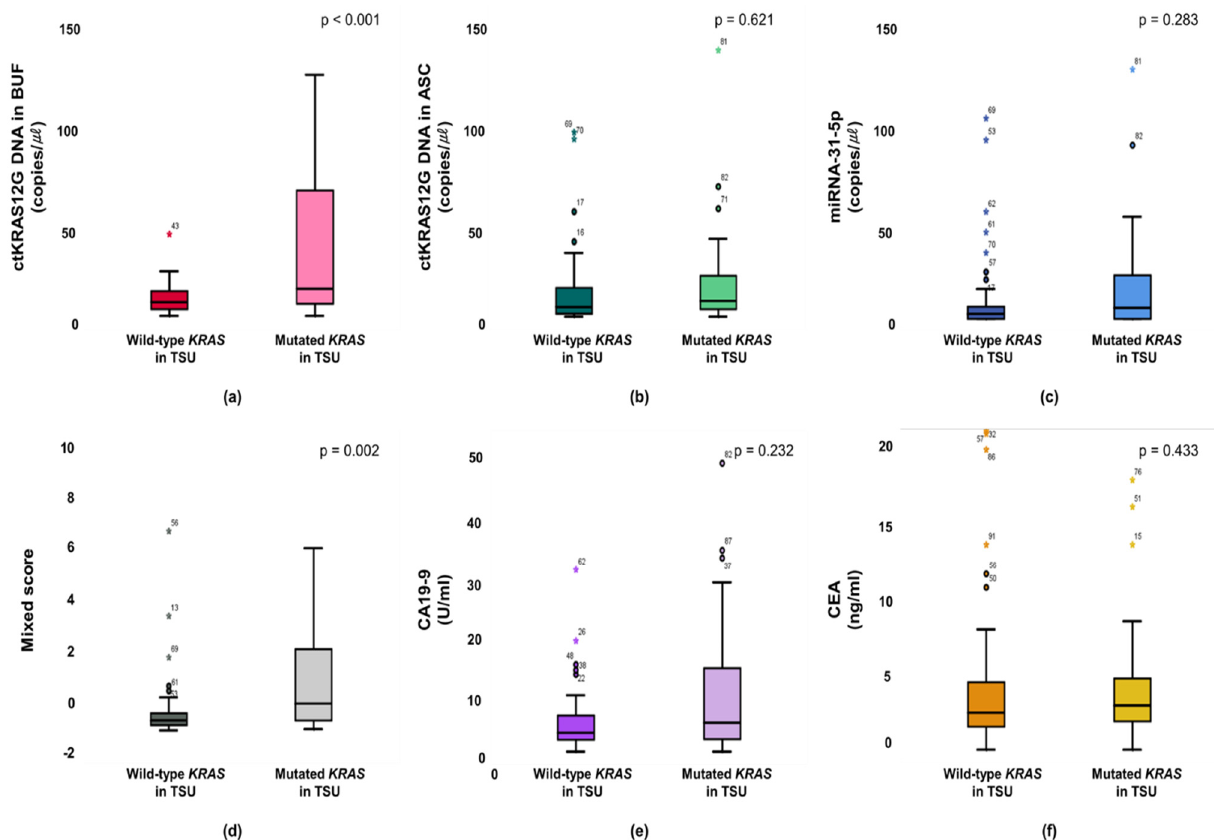
Figure 4. Primary statuses between mutant type and wild type KRAS are associated with the buffy coat ( a ), ascites ( b ), miR-31-5 ( c ), mixed score ( d ), CEA ( e ), and CA19-9 ( f ).